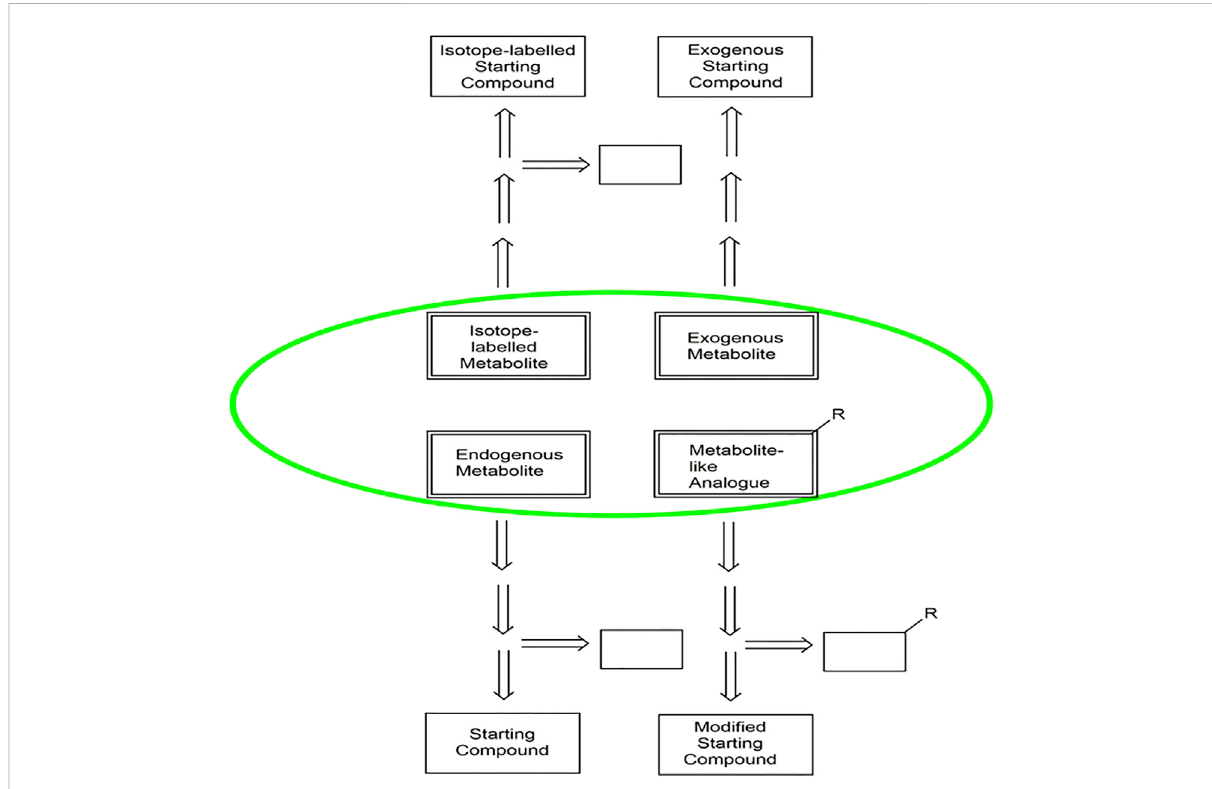
FIGURE 2 An overview of the selection of synthetic routes for endogenous metabolites, exogenous. metabolites, isotope-labelled metabolites and metabolite-like analogues, highlighted in. green. The arrows indicate the retrosynthetic pathways from the different classes of. metabolites to the starting compounds. The open boxes represent additional auxiliary. molecules in the different